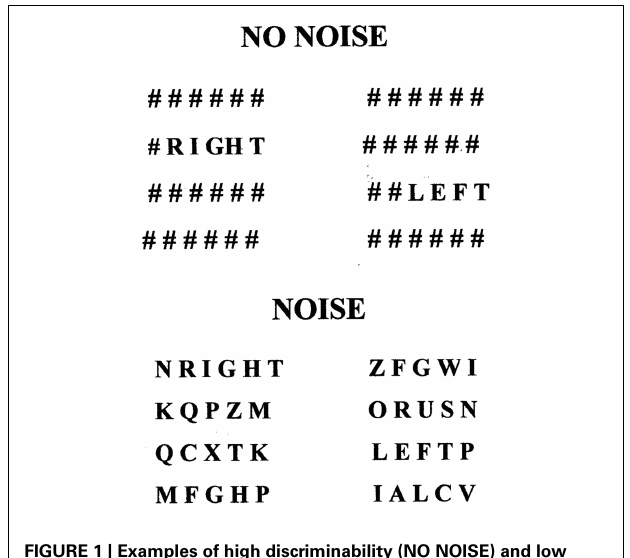
FIGURE 1 | Examples of high discriminability (NO NOISE) and low discriminability (NOISE) stimulus matrices used in the McCarthy–Donchin matrix task [modified from McCarthy and Donchin (1) ]